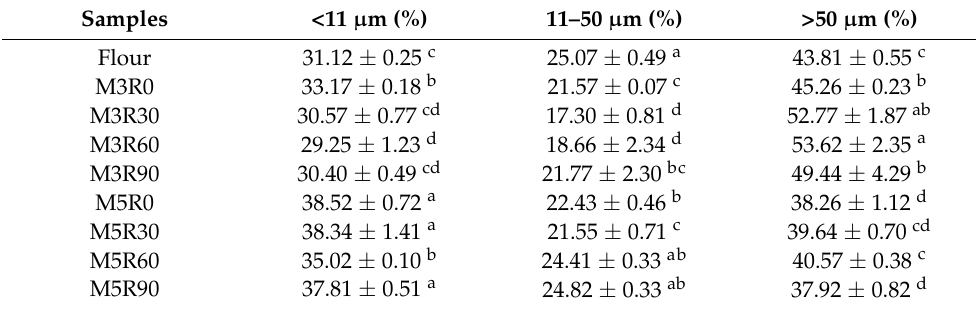
Figure 3. Particle size analysis of the GMP. Flour: wheat flour without mixing or resting. M3R0–M3R90: mixing for 3 min and resting for 0, 30, 60, and 90 min, respectively. M5R0–M5R90: mixing for 5 min and resting for 0, 30, 60, and 90 min, respectively. Table 2. Volume distribution of the GMP ( µ m) particle. Data are mean values ± standard variation of three replications and different letters indicate a significant difference at p < 0.05.